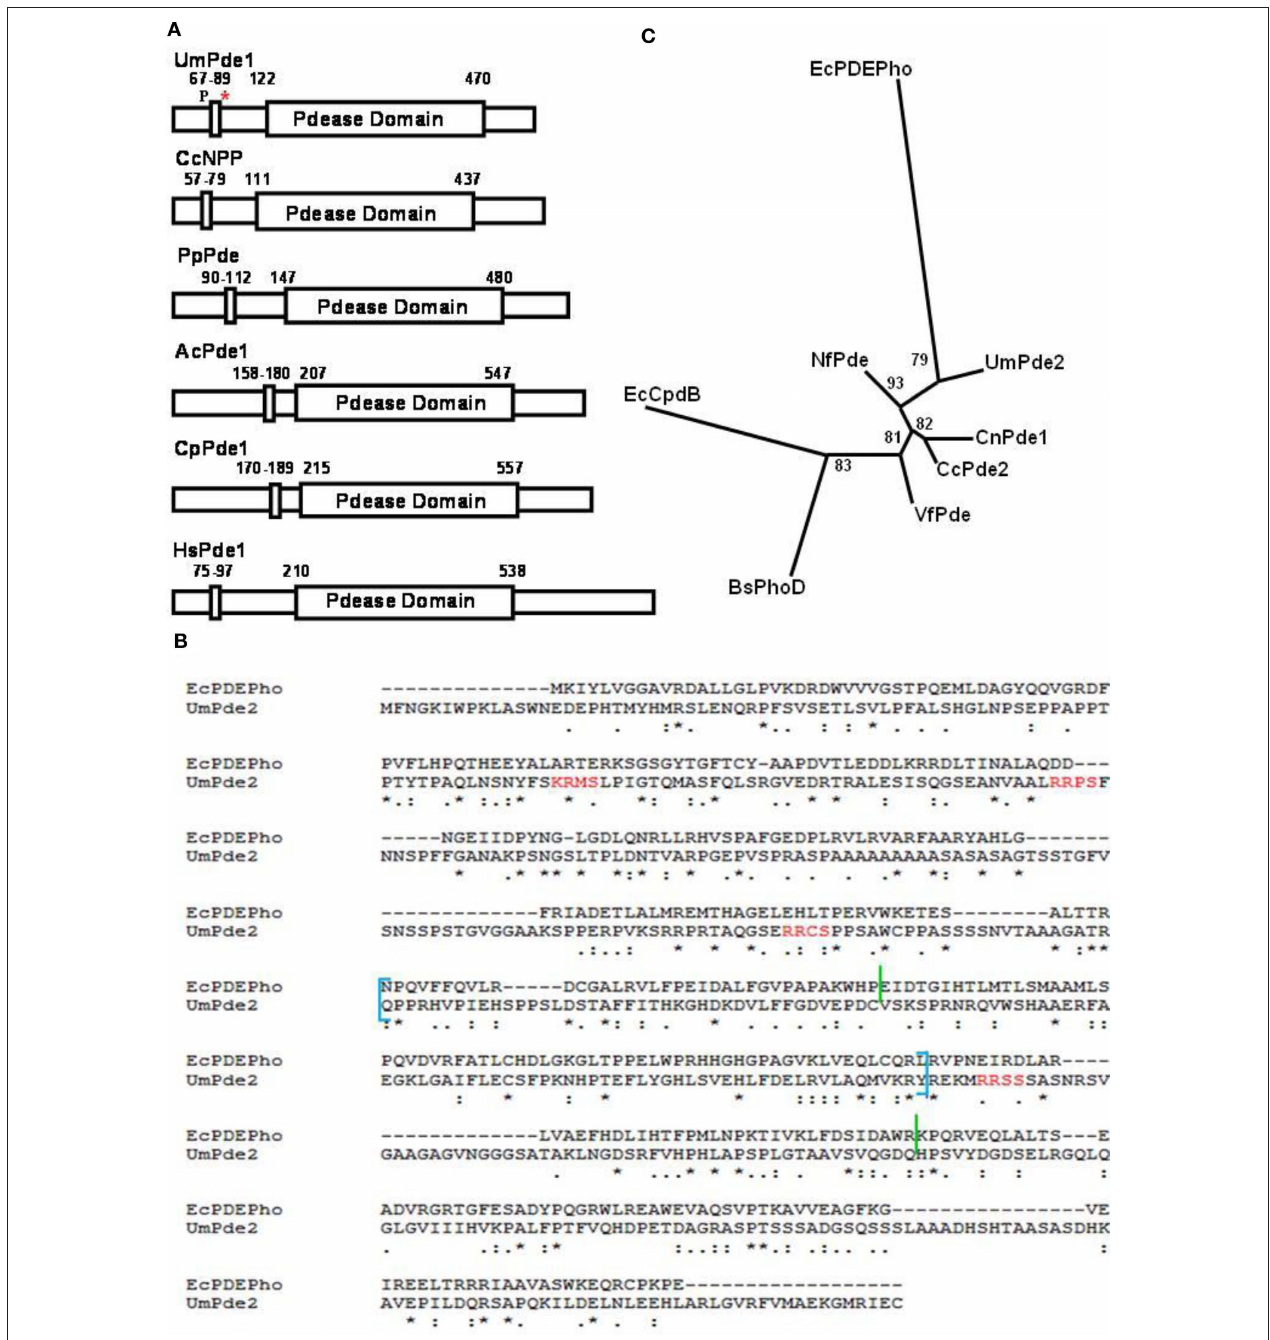
Figure 2 | Analysis of primary structure and phylogeny for umPde1 and umPde2. (A) Schematic diagram of UmPde1 with several closely related PDEs showing catalytic domain (indicated as large rectangles; COG 3379 for UmPde1, pfam 01663 for the remaining proteins) and transmembrane domain (small rectangles at N-terminal portions of the respective proteins, along with amino acid residue numbers comprising the domains). “P” indicates putative phosphorylation site by PKA in UmPde1; *, represents location of the 5 ′ primer used to produce a gene encoding a version of UmPde1 lacking the predicted membrane-spanning domain; (B) Alignment of UmPde2 primary sequence with that for EcPDEPho (NCBI Accession No. AP_003606). EcPDEPho is an Escherichia coli fused tRNA nucleotidyl